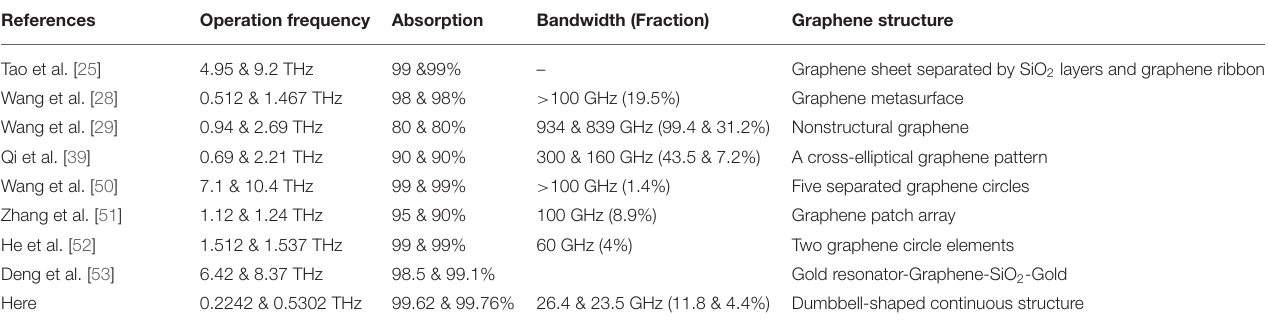
TABLE 1 | Comparisons between the designed absorber and the reported results.